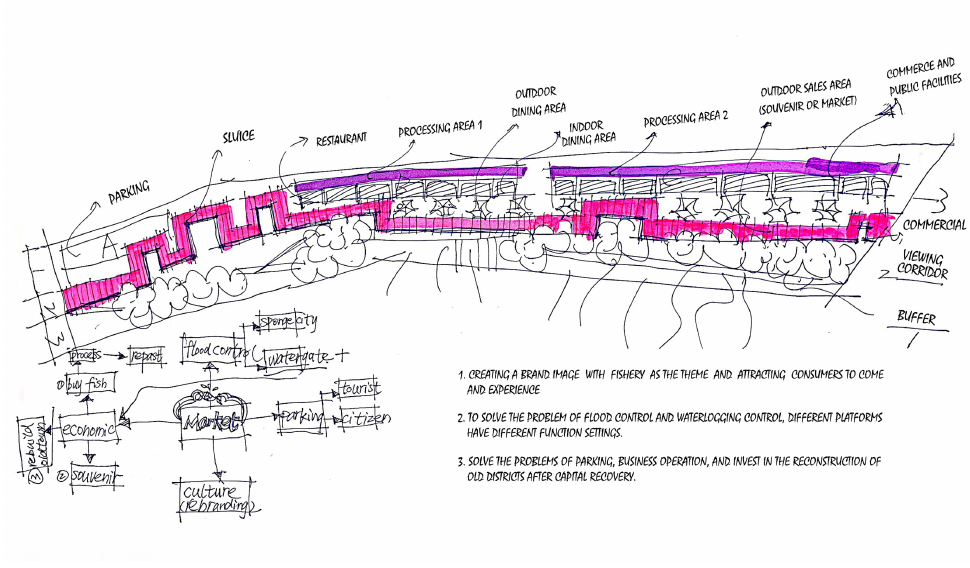
Fig. 5 Draft overall design concept for the Inner Harbour